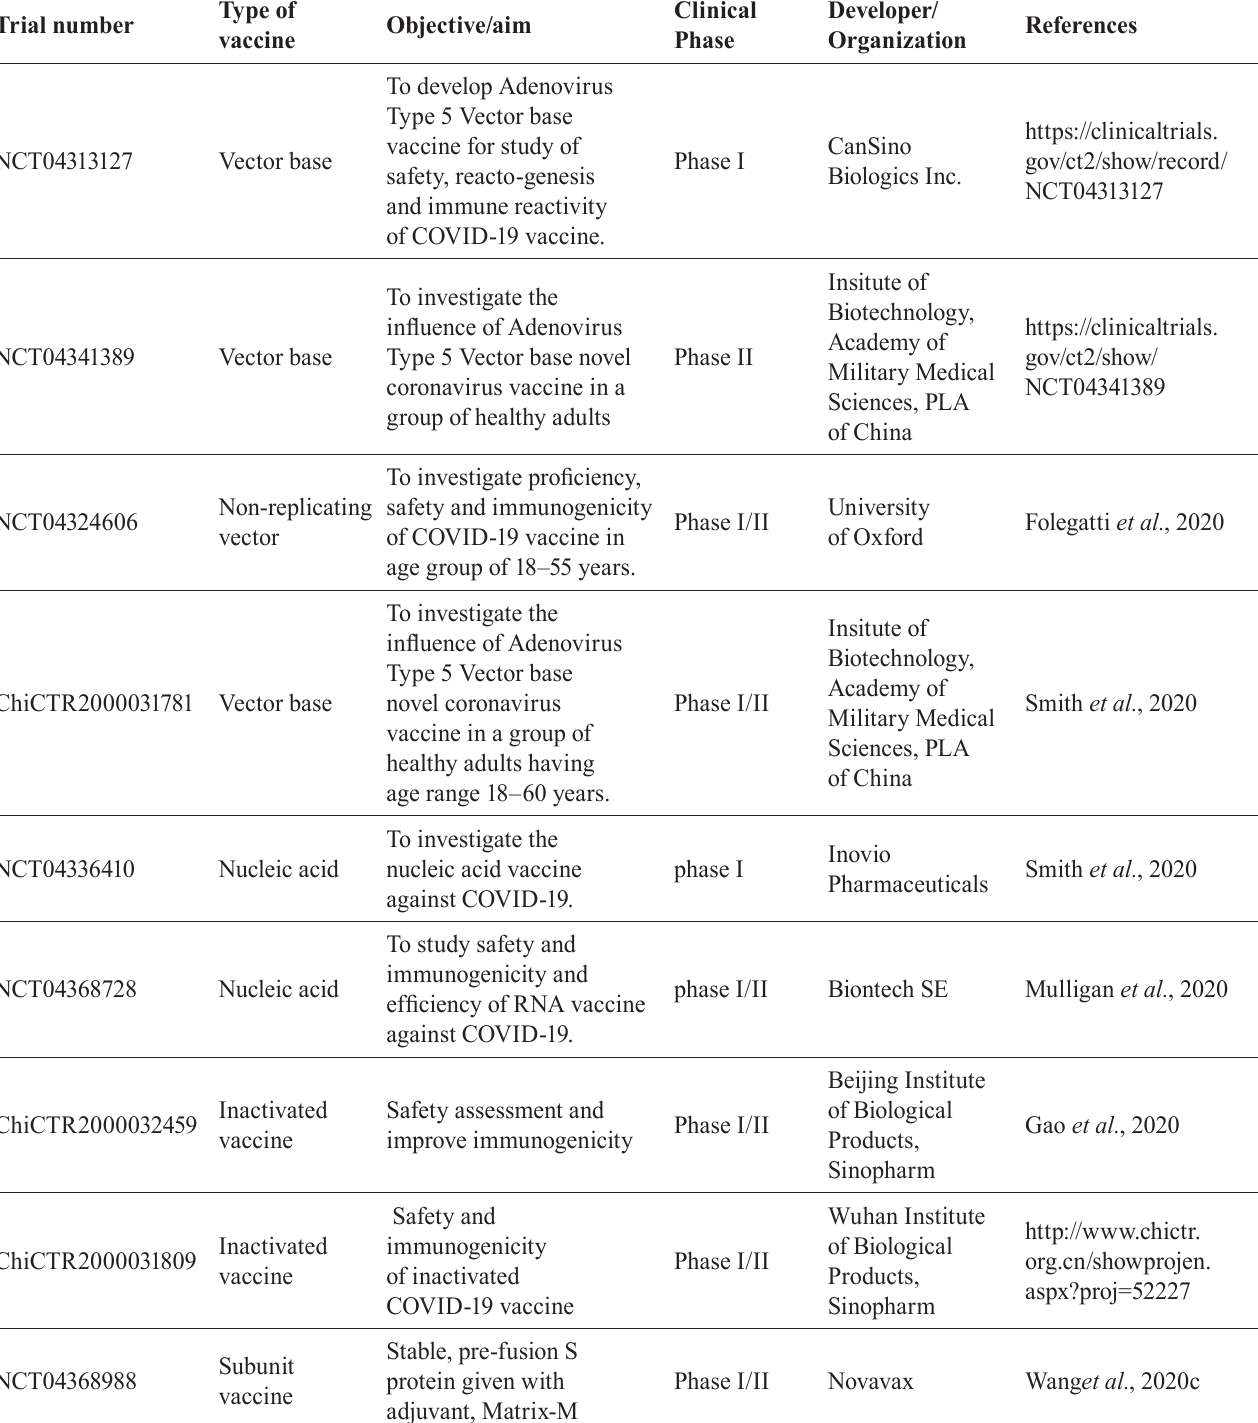
TABLE II - Coronavirus vaccines which are under clinical trials